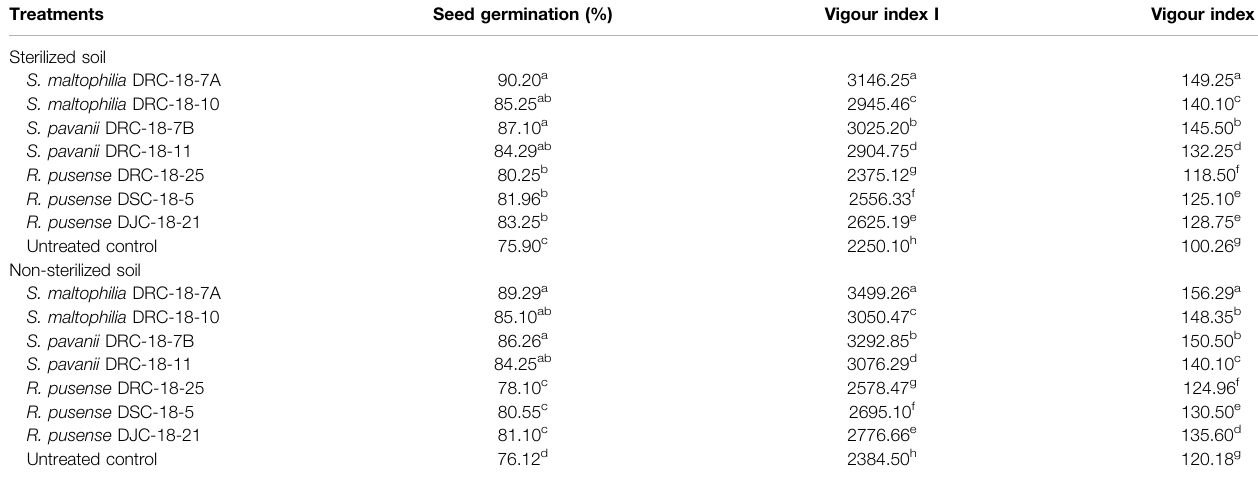
TABLE 2 | Effect of seed inoculation of SOB on germination (%) and vigour indices of pigeonpea grown in pots after 15 and 30 days of sowing, respectively.